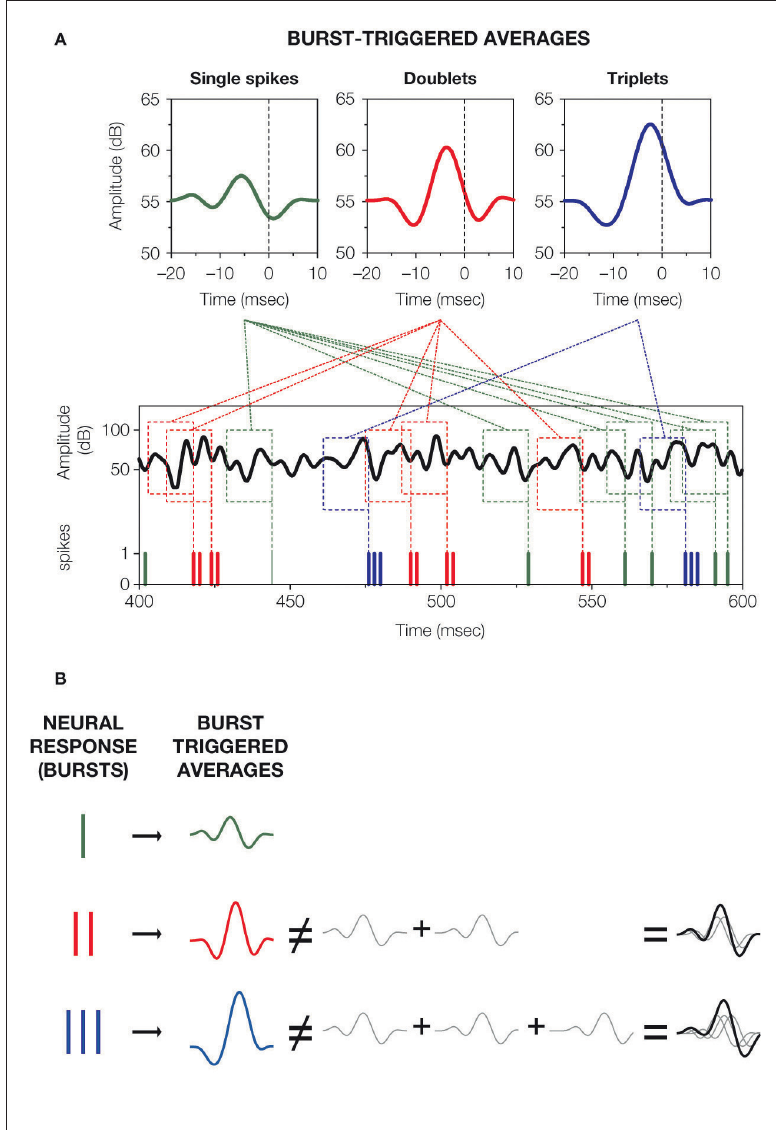
Figure 2 | The burst-triggered averages (BTAs) corresponding to bursts of different durations. (A) Calculation of BTAs. The stimulus stretches preceding bursts of exactly n spikes are aligned with respect to the first spike in the burst, and averaged together. For all cells, BTAs exhibit a central peak, on top of a noisy background. The size of the peak increases with the number of spikesin the burst. (B) The BTA corresponding to doublets is larger than the one that would be obtained by summing up two copies of the BTA of single spikes, displaced from one another by one ISI. The same holds for triplets and